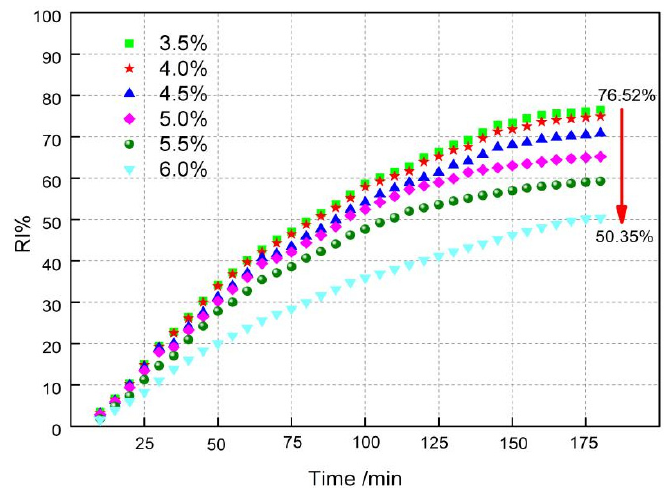
Figure 9. Effect of fuel content on the RI of RVT sinter.